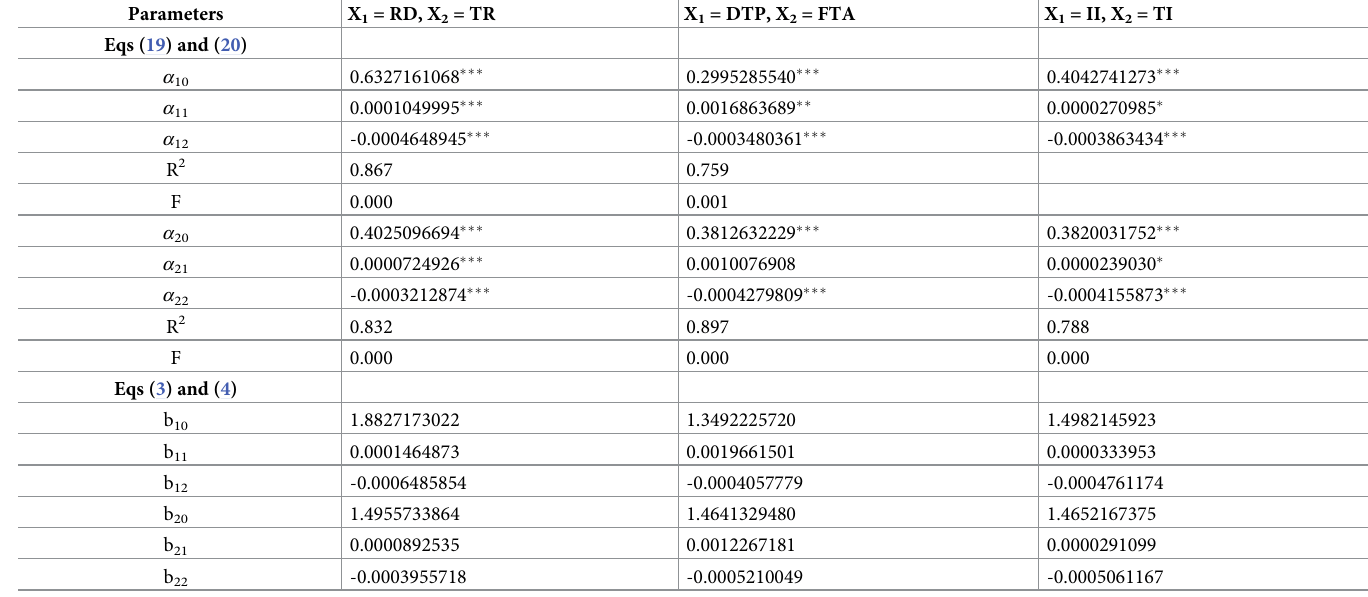
Table 9. Parameter estimation and calculation with the gray method for the Lotka-Volterra model.